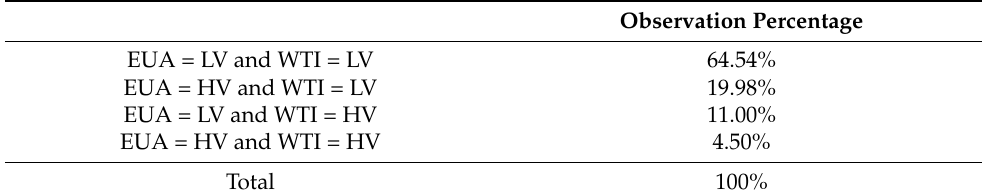
Table 6. Observation percentage of various volatility